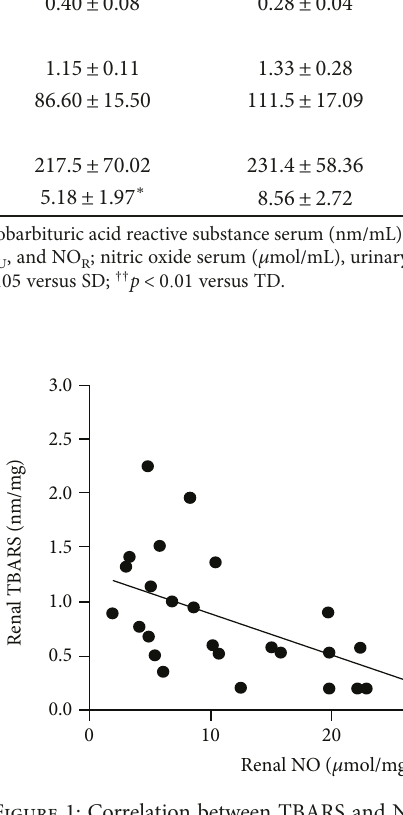
Figure 1: Correlation between TBARS and NO renal levels of SC, TC, SD, TD, and PTD rats. n = 5 for all groups. Pearson ’ s correlation, r = − 0 54 , p < 0 01